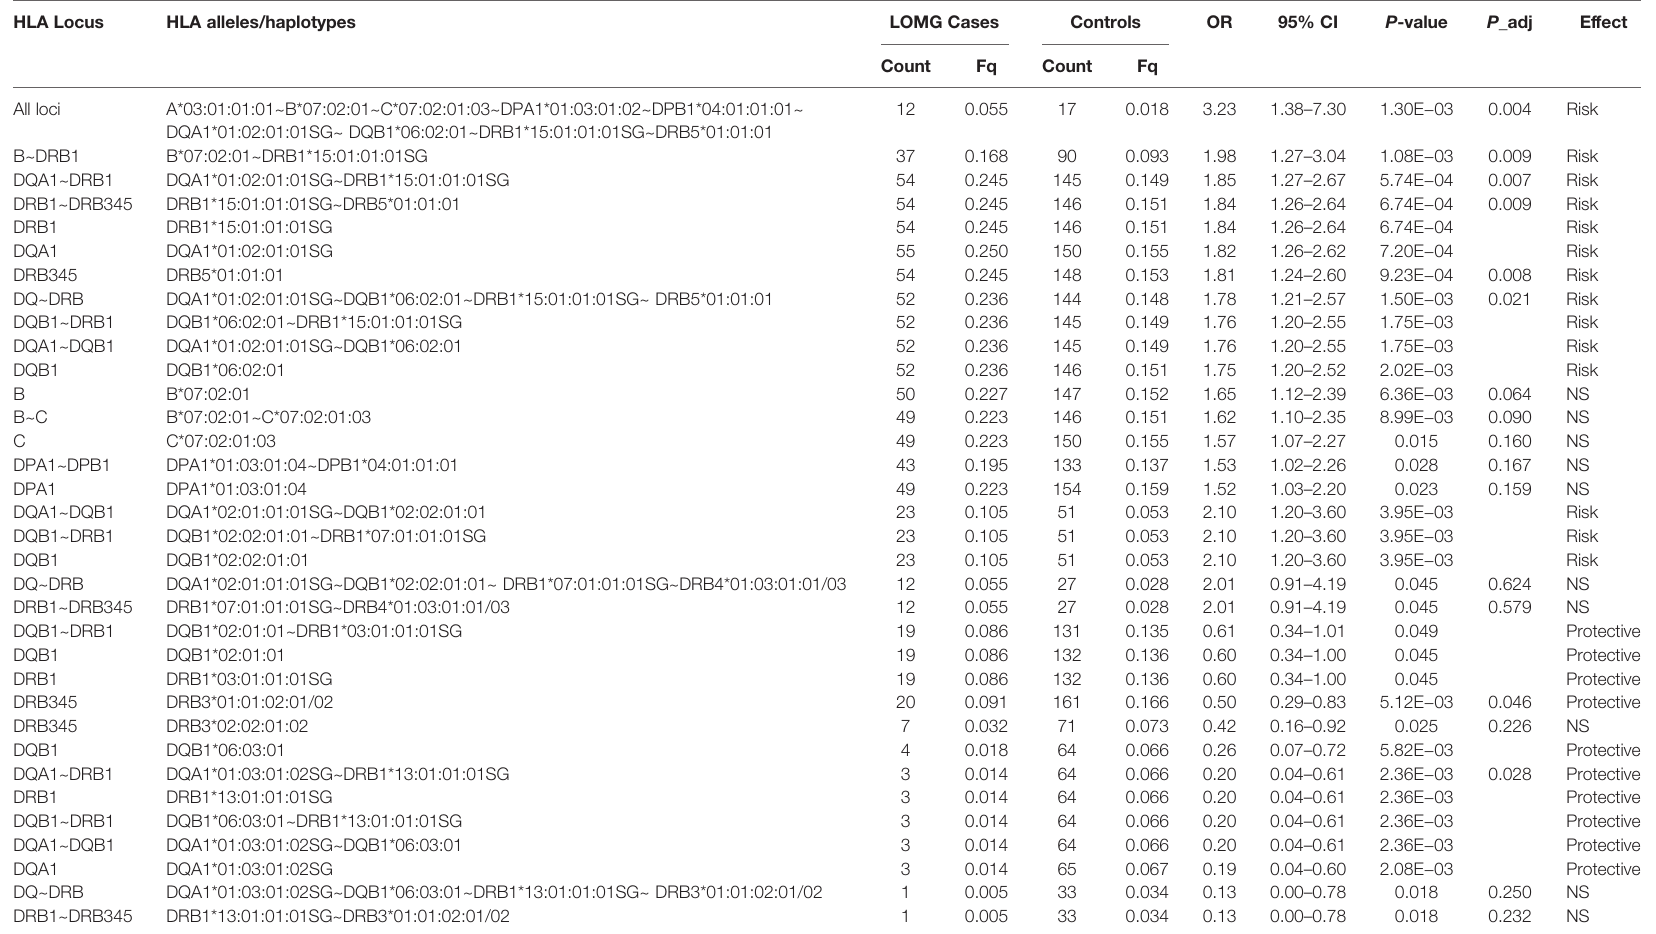
TABLE 6 | Signi fi cant associations of HLA alleles and haplotypes in Norwegian LOMG AChR-antibody positive cases and controls ranked by odds ratios. HLA Locus HLA alleles/haplotypes LOMG Cases Controls OR P -value